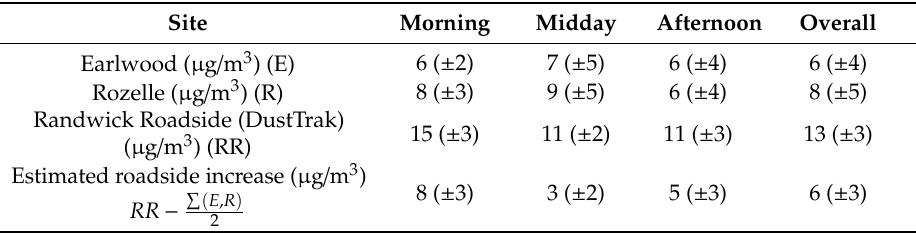
Table 2. Comparison of hourly average PM 2.5 concentrations between roadside (main streets only) and air quality monitoring stations. Estimated roadside increase in PM 2.5 is calculated as Randwick Roadside minus the mean of Earlwood and Rozelle. Overall results are shown along with morning rush (07:00–09:30), midday (09:30–16:00), and afternoon rush (16:00–19:00) times.